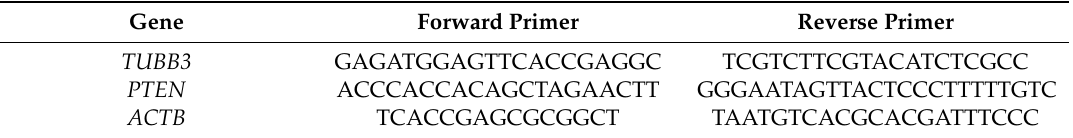
Table 2. Primers sequences for quantitative reverse transcriptase polymerase chain reaction